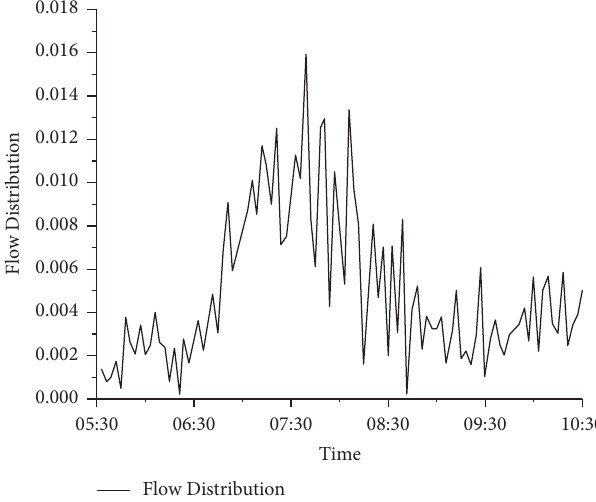
Figure 4: Frequency distribution of card swiping from 5:30am to 10:30